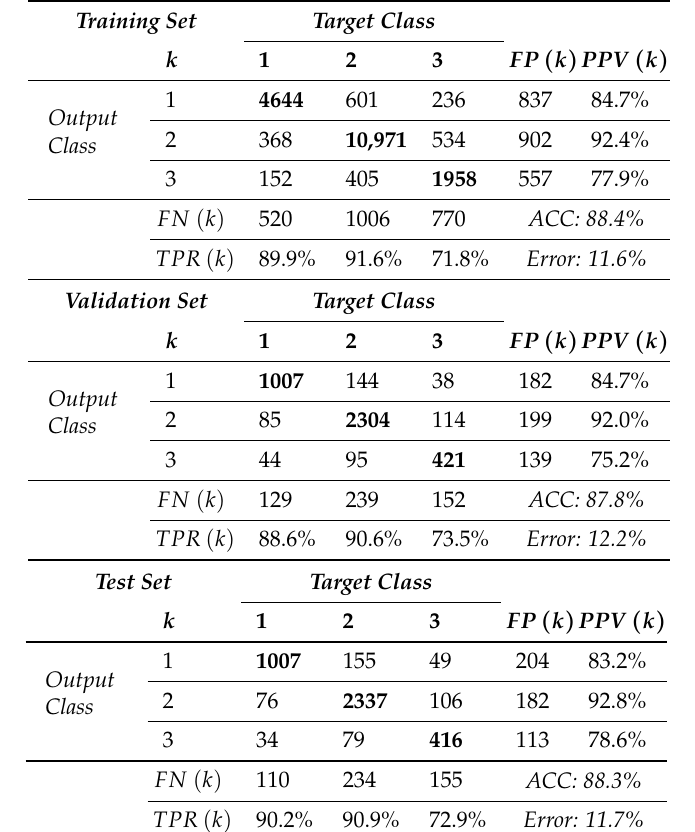
Table 7. Confusion matrix of the classification neural network model for the training, validation, and test sets of sleep stages (for healthy individuals) with true positive values on the matrix diagonal (in the